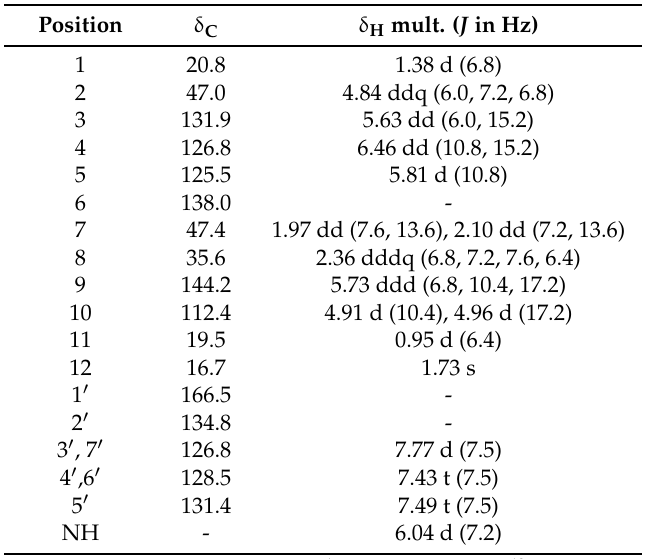
Table 1. NMR data for haliamide ( 1 ) in CDCl 3 .